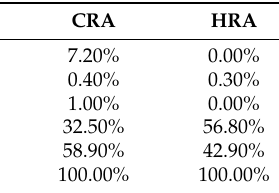
Table 5. Detailed composition of product